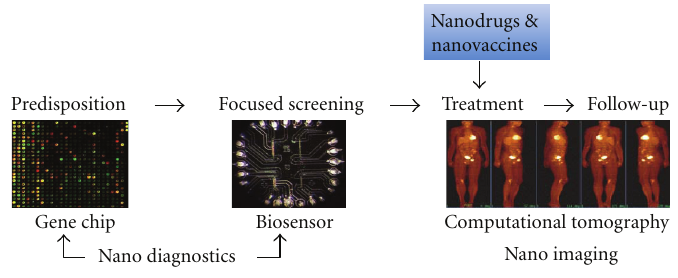
Figure 2: Nanotechnologies in